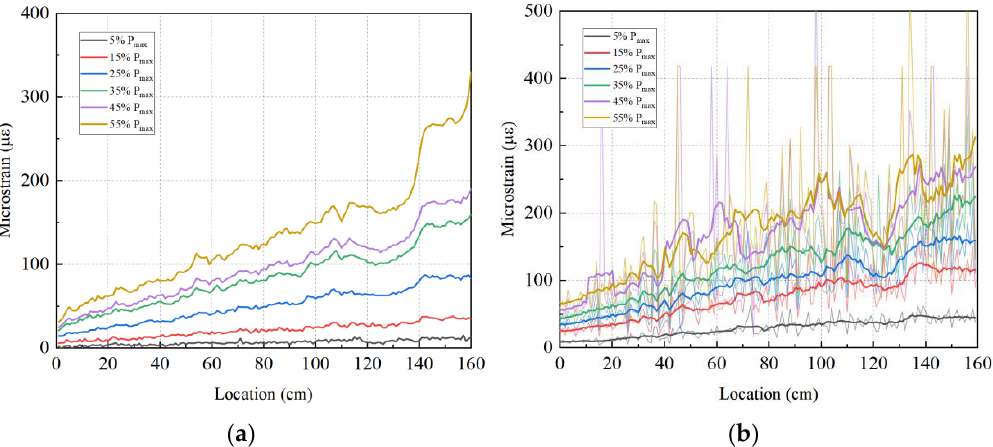
8 of 17 Figure 5. Strain profile at the bottom of precast prestressed bent cap under rising load: ( a ) Fiber V1 on side A; ( b ) Fiber J1 on Side B. Figure 6 shows a graph of the strain data obtained by the two types of optical fibers. The data show that the J1 fiber with a polyimide coating exhibits a larger local strain fluc- tuation. This fluctuation is relatively small in the low loading stages, and it gradually in- creases with the load. The data profile of the multi-coated fiber is smoother. Table 1 gives the average and variance of the strain increments between adjacent points for different fibers at different load levels. The strain increment parameter reflects the sensitivity of the fiber to structural strain. The mean value of the strain increment of J1 fiber is similar to that of V1 fiber, but the variance is much higher. When the load is 5% of Pmax, the mean value of strain increment at the adjacent point of J1 is 0.23 με , and the variance is 163.8